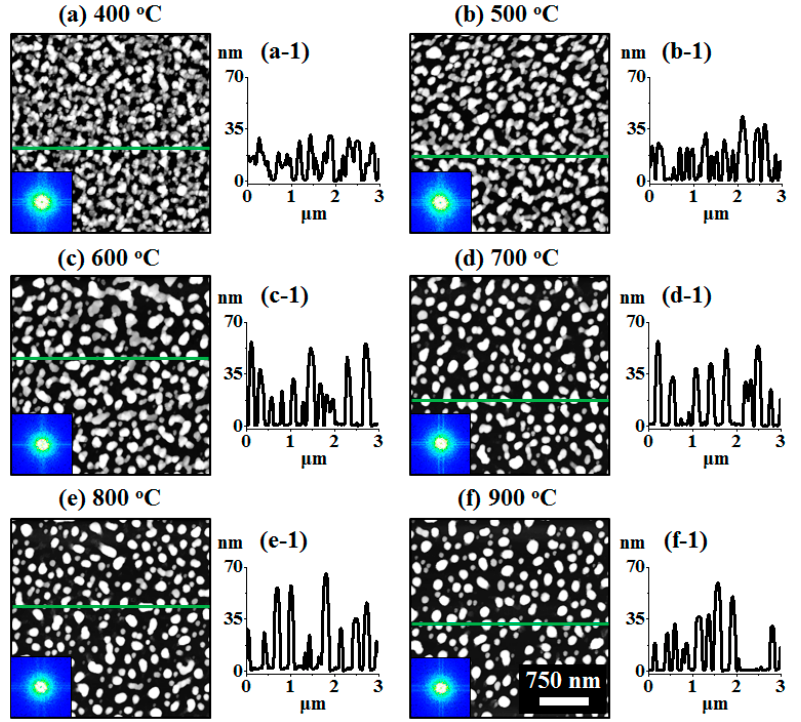
Figure A8. ( a – f ) Large scale AFM top-views of Pd–Au–Ag tri-metallic nanostructures annealed temperature between 400 and 900 °C (Tri-layer of Pd–Au–Ag of total thickness 6 nm and equal composition). ( a - 1 – f - 1 ) Cross-sectional line-profiles. Insets in ( a – f ) are FFT power spectra.